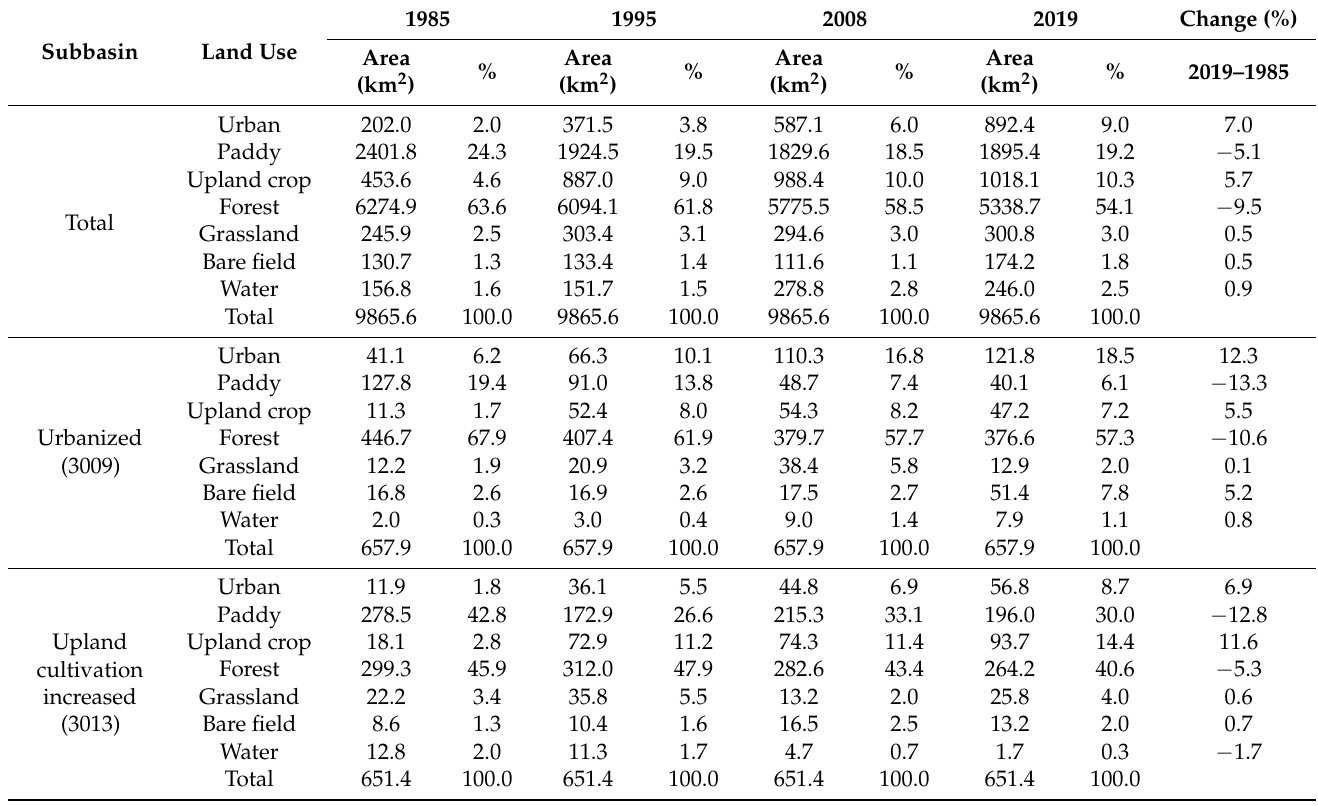
Table 2. Land-use occupation in the